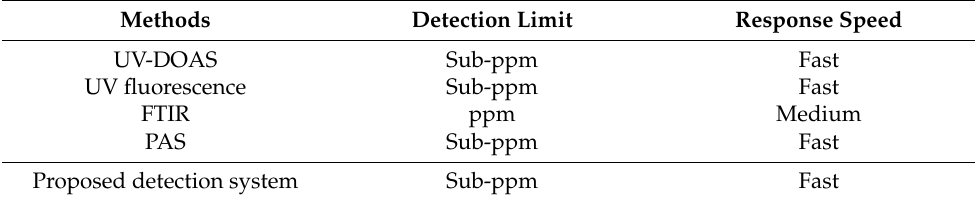
Table 4. Comparison of the performances of common optical detection